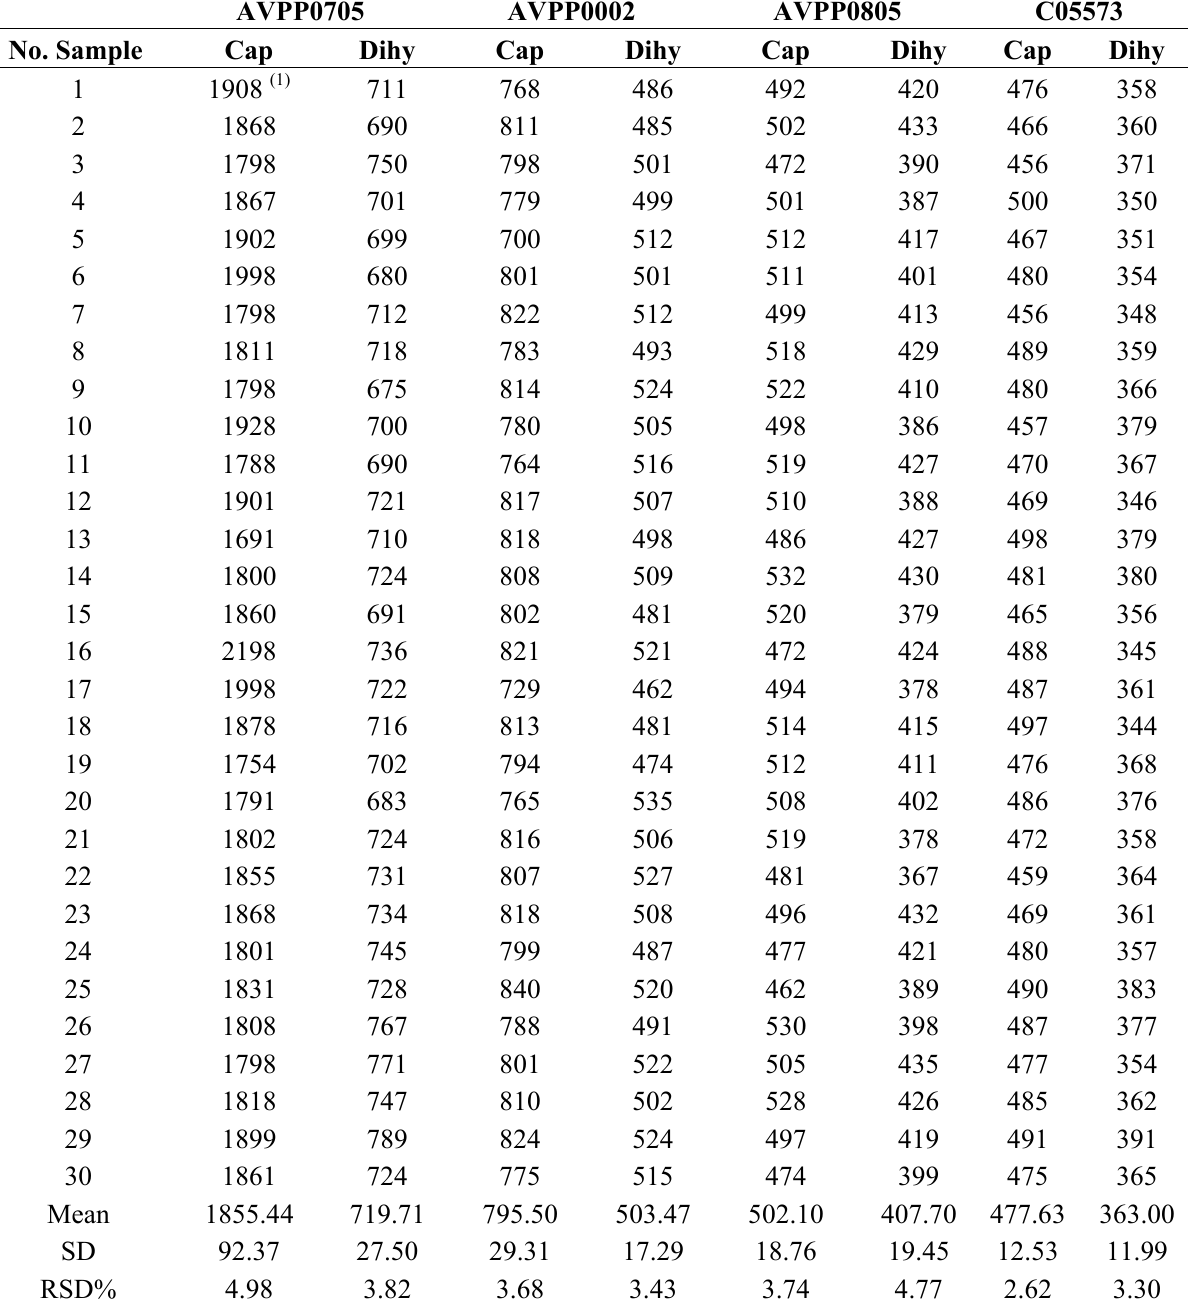
Table 2. Inter-day reproducibility data of the UFLC method for the determination of capsaicinoids in pepper